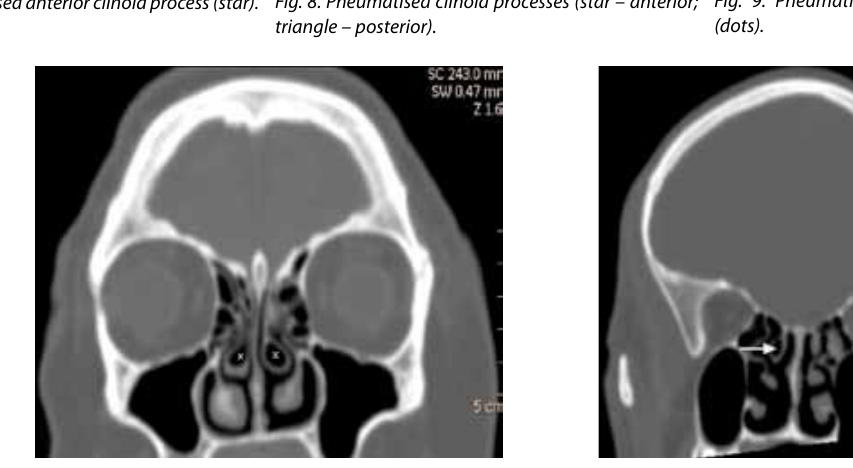
Fig. 9. Pneumatised uncinate processes, bilaterally (dots).Fig. 8. Pneumatised clinoid processes (star – anterior;